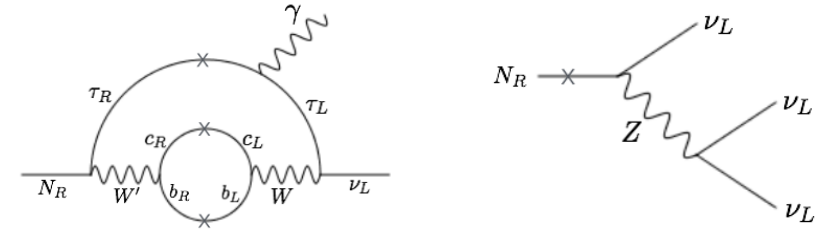
Figure 5 . Decay modes of N R . The radiative decay (left) is induced by its coupling to W 0 as dictated by the (cid:12)t to the R ( D ( (cid:3) ) ) signal. The tree level decay to neutrinos (right), induced